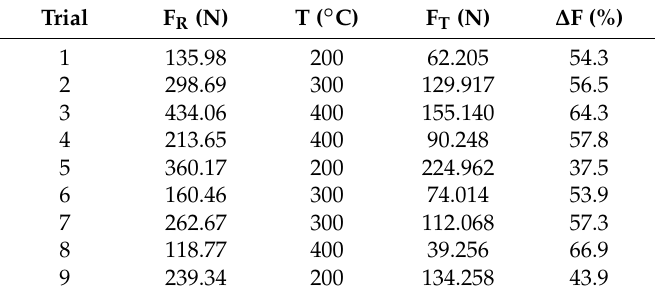
Figure 8. Cutting force with cutting parameters at V c = 190 m/min, f = 230 mm/min, t = 0.5 mm in conventional and thermal-assisted machining. Table 10. Comparison of cutting force in conventional and thermal-assisted machining.